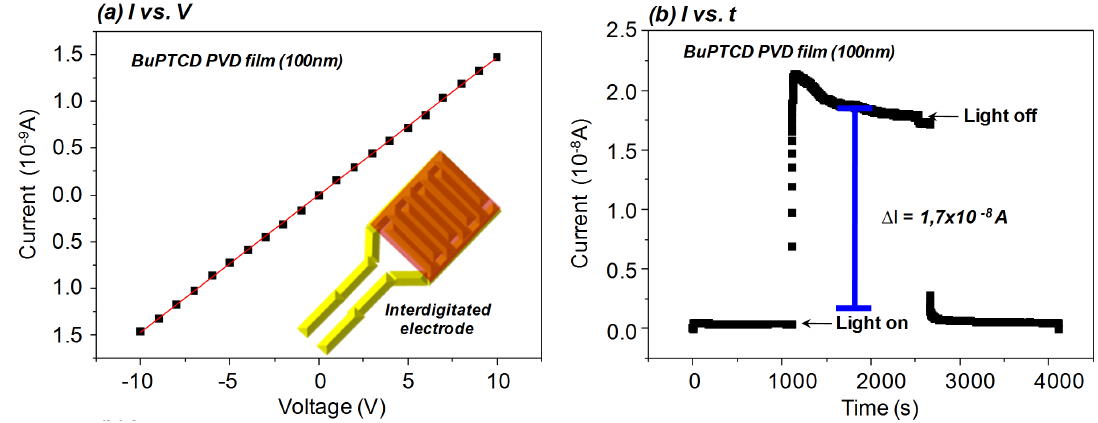
Figure 8. (a) I vs. V curve for the 100 nm PVD film of BuPTCD deposited onto Au interdigitated electrodes. The inset depicts the Au interdigitated electrode covered by BuPTCD PVD film. (b) I vs. t curve for the 100 nm PVD film of BuPTCD deposited onto Au interdigitated electrodes when irradiated with a halogen lamp at 150 mW/cm 2